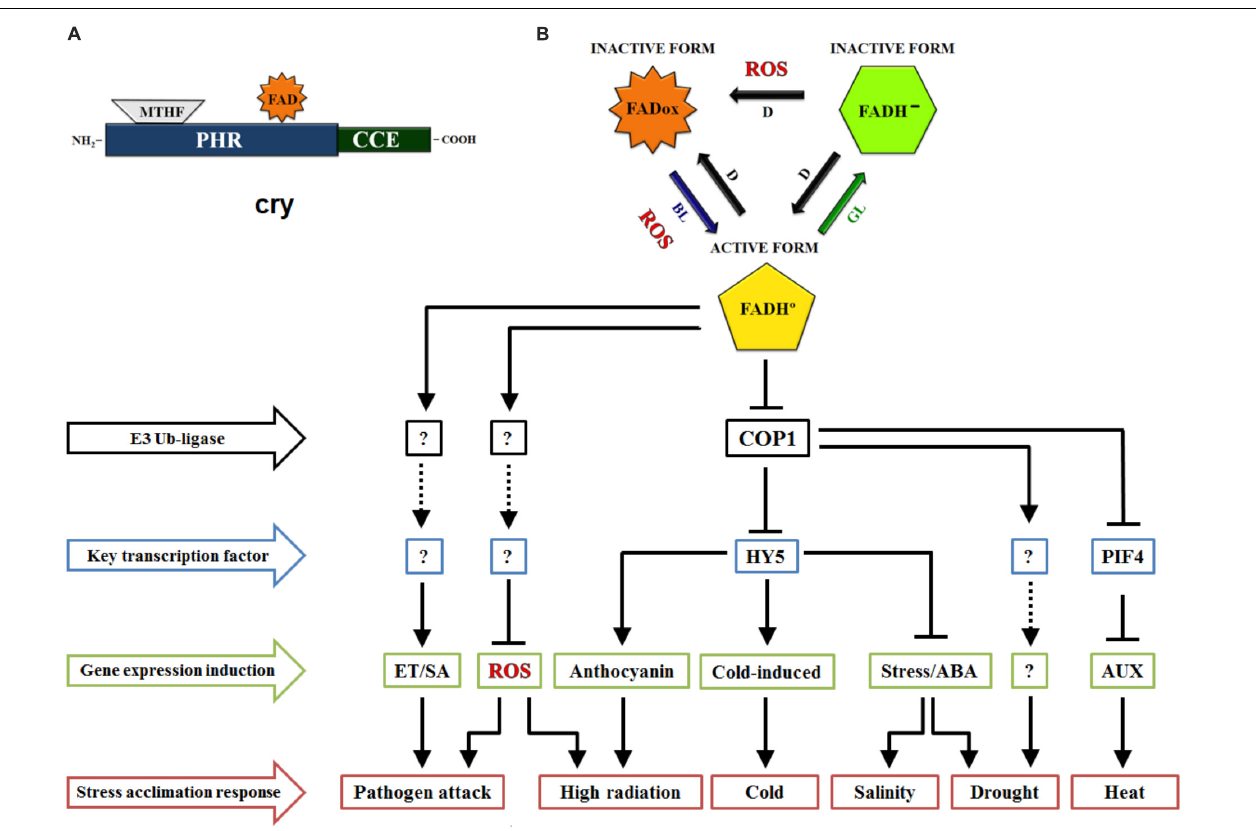
FIGURE 1 | Schematic view of cryptochromes (cry) role in stress acclimation responses. (A) Domain structure of cry consists of Photolyase-Homologous Region (PHR) domain and CRY C-terminal extension (CCE) domain. The cry chromophores methenyltetrahydrofolate (MTHF) and FAD are binding to PHR, a light perception domain. (B) FAD chromophore redox states of cry. FAD is oxidized (FADox) in the darkness (D), with the absorption peak in blue light (BL). On light exposure, FADox changes to the neutral semireduced state (FADH ◦ ), which allows the biological activity of cry in the plant cell. With the absorption peak in green light (GL), FADH ◦